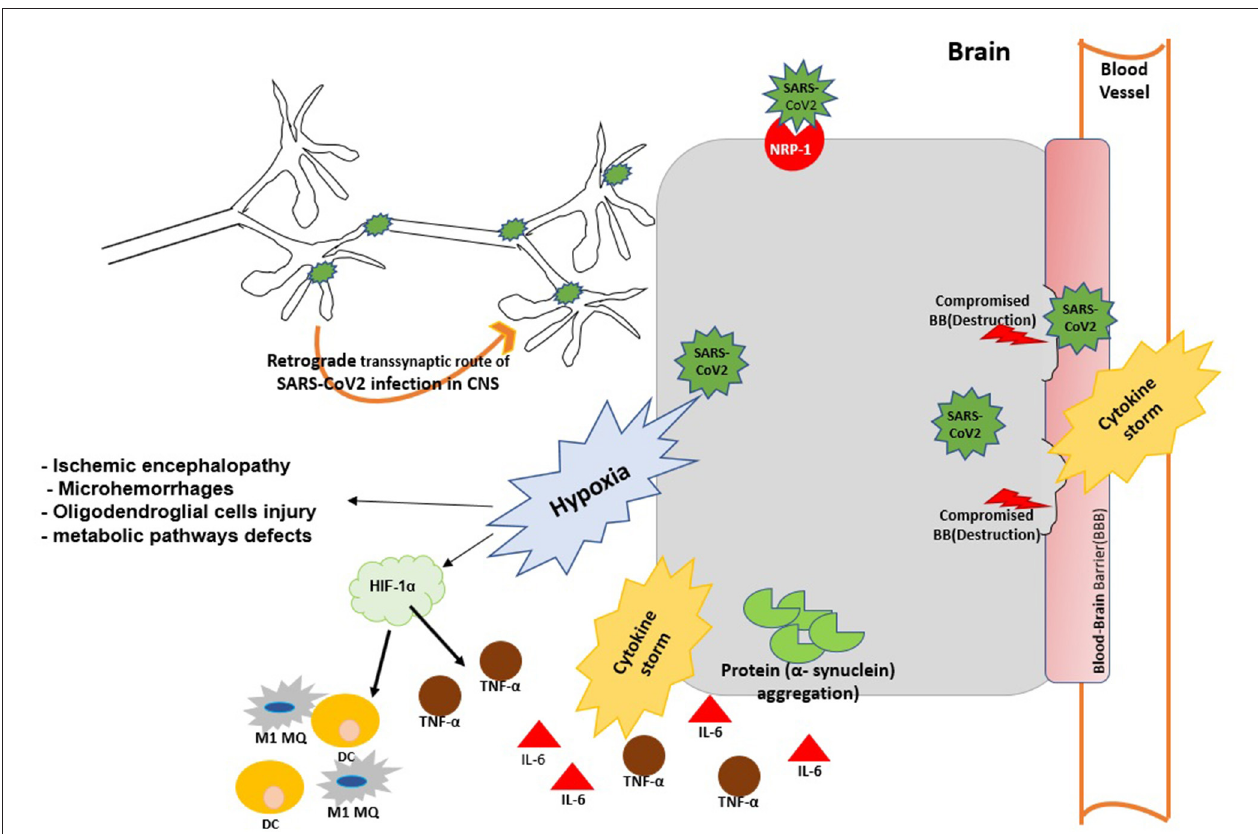
FIGURE 1 | The possible mechanisms of virus entry to CNS and brain injury during SARS-Cov2 infection. SARS-Cov2 can reach the central nervous system (CNS) by retrograde transmission along the peripheral nervous system; by activation of the neuropilin-1 (NRP1) receptor; via the systemic circulation and disruption of the BBB. Viral infection can cause aggregation α -synuclein and trigger α -synucleinopthies. Viral replication triggers cytokine storm and case to vascular leakage and BBB disruption. Virus infection may trigger brain hypoxia during which hypoxia inducible factor 1 (HIF-1 α ) is activated in the brain and promotes the production of IL-6 TNF- α and M1 MQ polarization at the site of infection. Hypxia in the brain impairs metabolic pathways and further promotes neurodegeneration and brain